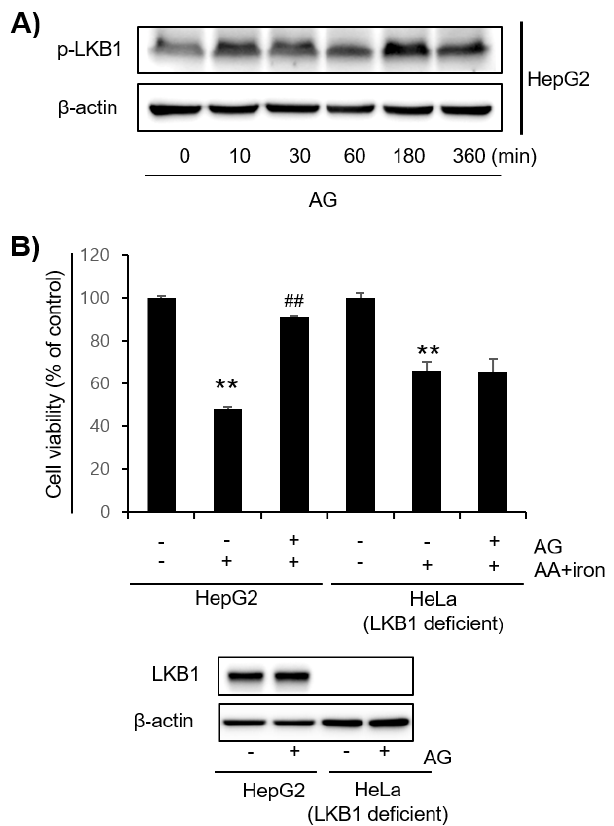
Figure 4. Expression effect of LKB1 by AG ( A ) Western blotting of phosphorylation of LKB1, an up- stream regulator of the AMPK signaling pathway. HepG2 cells were incubated with AG (100 µ g/mL) for the indicated times. ( B ) Effect of AG on AA + iron-induced apoptosis on HepG2 and LKB1- deficient HeLa cells. The cells were pretreated with AG (100 µ g/mL) for 1 h, followed by AA (10 µ M) for 12 h and iron (5 µ M) for 6 h. The MTT assay was performed for cell viability. LKB1-deficient was confirmed by Western blotting. The cells were treated with AG (100 µ g/mL) for 1 h. The graph represents the means ± SD of three independent experiments (** p < 0.01 vs. control group; ## p < 0.01 vs. AA + iron-treated group). AA, arachidonic acid; AG, Angelica gigas